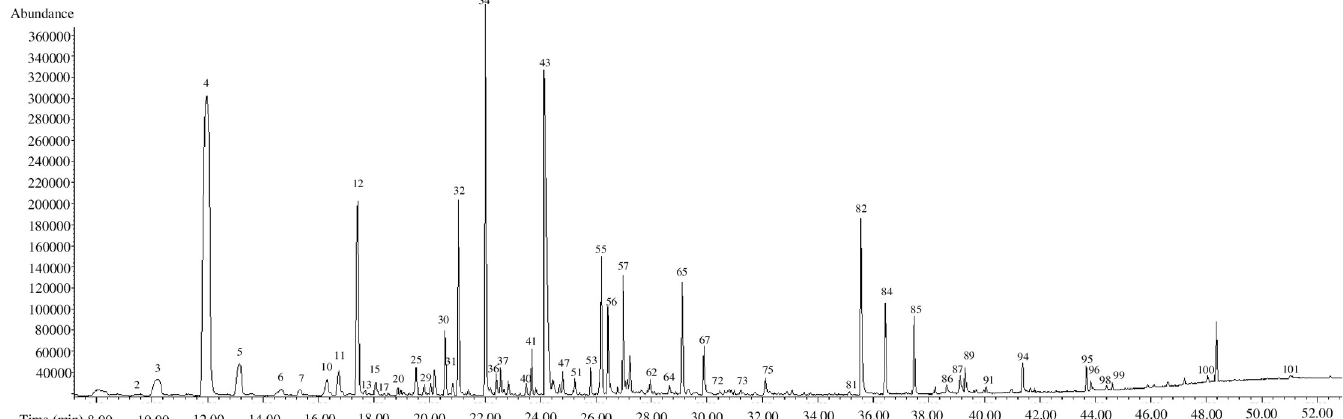
Fig 3. GC-MS/FID chromatogram of Lonicera japonica Flos (Shandong) extracted by HS-SPME at the extraction conditions of 80˚C and 30 min. The numbers of each peak correspond to the compounds in S1 Table.